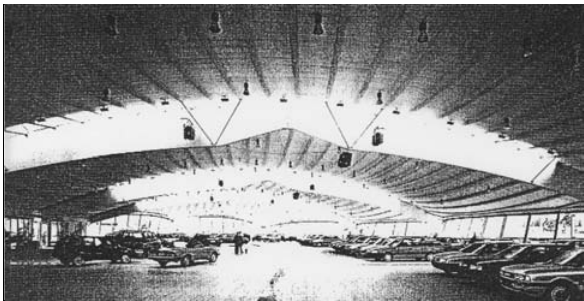
Fig 7. A fire-proof ventilated saddle roof makes an excellent use of natural